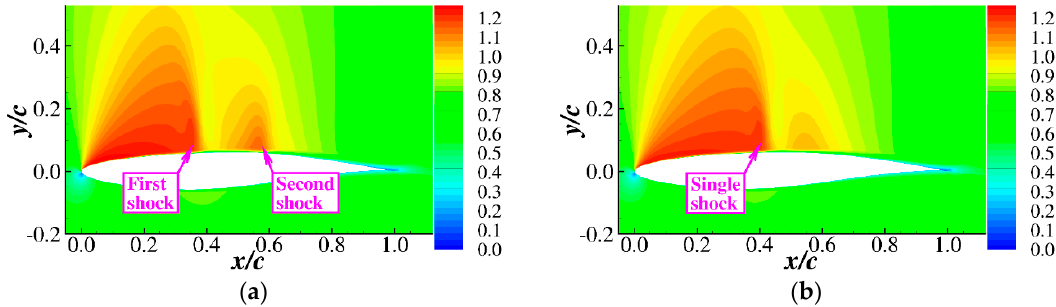
Figure 17. Flow fields of airfoils at Ma = 0.72, Re = 6.5 × 10 6 , C L = 0.800. ( a ) c p,x = 0.40; ( b ) c p,x = 0.05. Figure 16. Pressure distributions at different Mach numbers ( Re = 6.5 × 10 6 , C L = 0.800). ( a ) Ma = 0.65; ( b ) Ma = 0.72; and ( c ) Ma = 0.74.